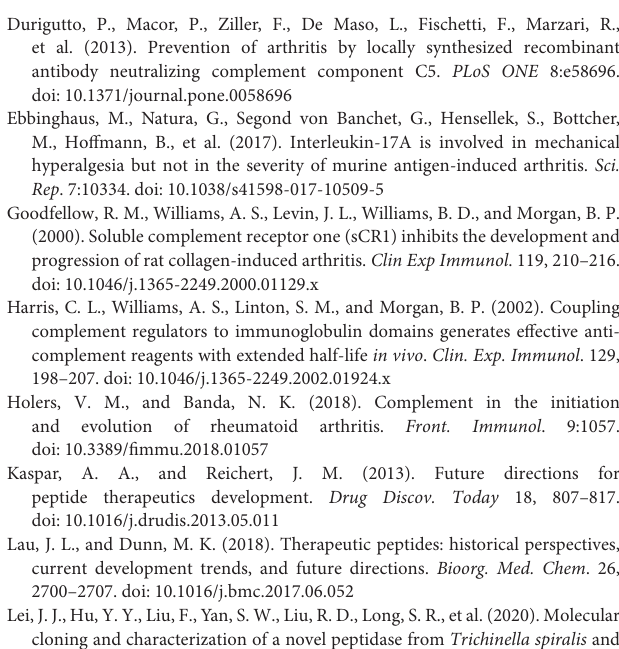
Supplementary Figure 1 | Representative histologic sections of murine knee joints stained with hematoxylin and eosin. (A) The left knee of mouse injected with mBSA in AIA only group; (B) The right knee of mouse injected with PBS in AIA only group. Magnification ×